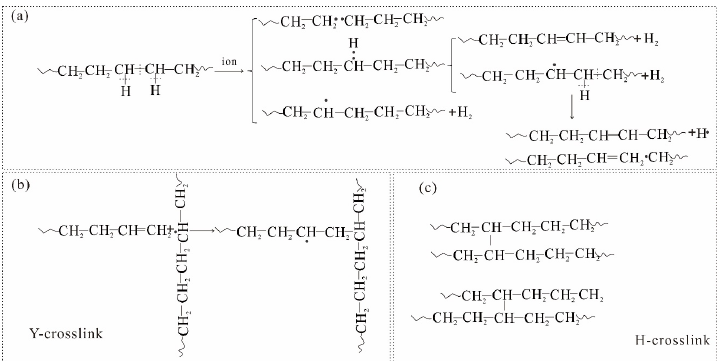
Figure 7. A series of reactions after surface activation: ( a ) different products generated after the breaking of macromolecular chain of UHMWPE surface treated with carbon plasma, ( b , c ) segments of UHMWPE react to form Y crosslinks and H crosslinks.